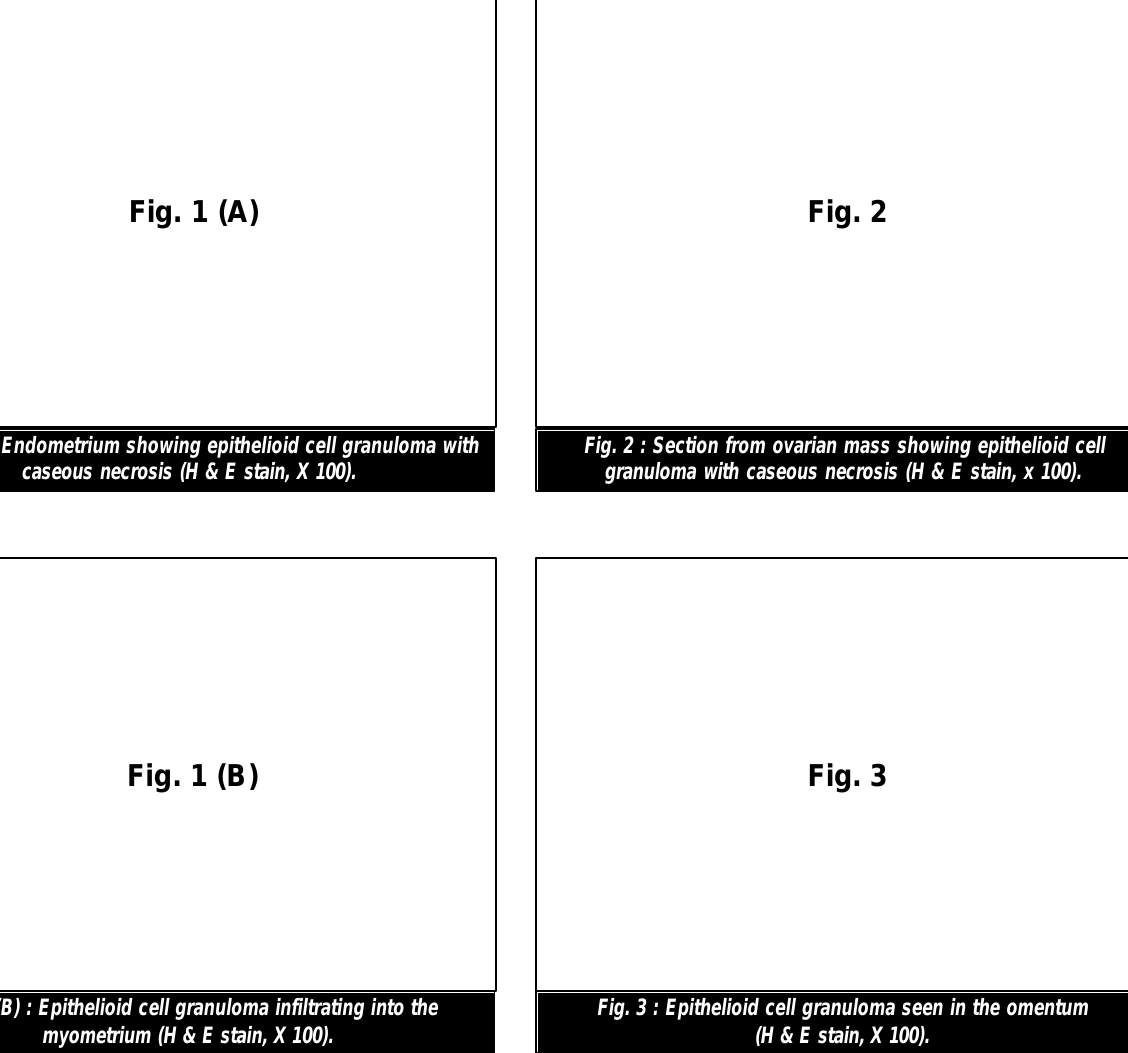
Fig. 1 (B) : Epithelioid cell granuloma infiltrating into the myometrium (H & E stain, X 100).